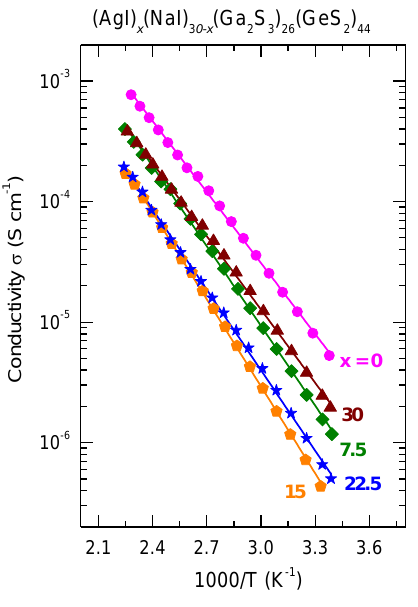
Figure 5. Temperature dependence of the total electrical conductivity σ for the (AgI) x (NaI) 30 − x (Ga 2 S 3 ) 26 (GeS 2 ) 44 (x = 0; 7.5; 15; 22.5 and 30 mol.% AgI) glasses. The solid lines represent a least-square fit of the data to Equation (2).